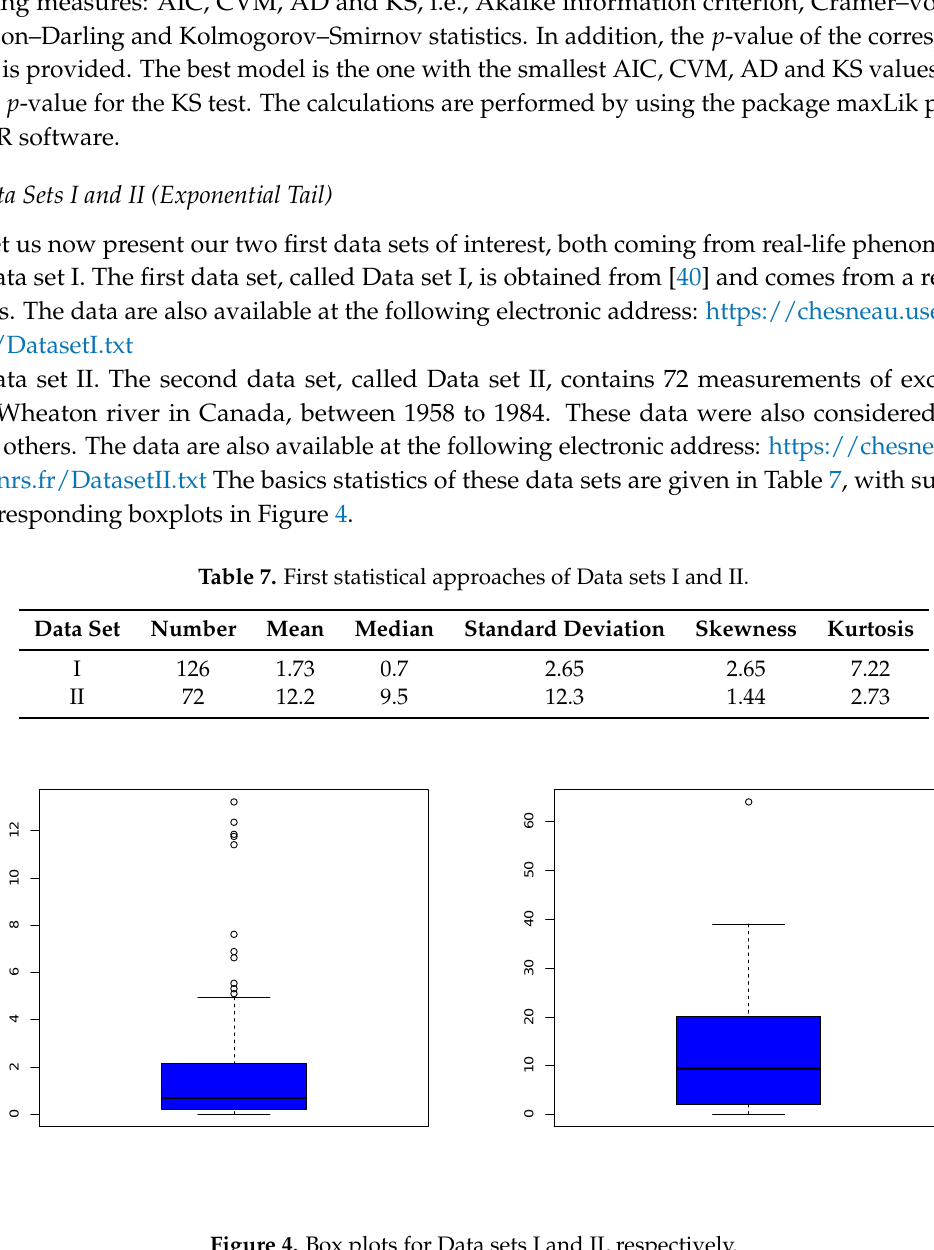
Figure 4. Box plots for Data sets I and II,